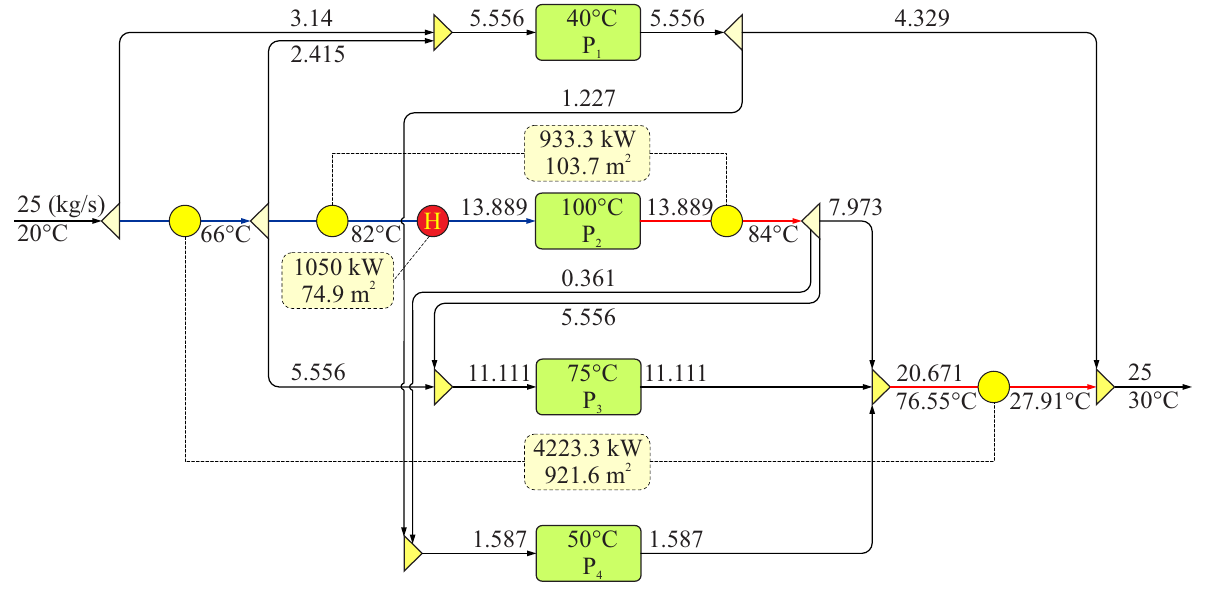
Figure 10. Optimal network design for Example 1. Table 3. Comparison of the results with those from the literature for Example